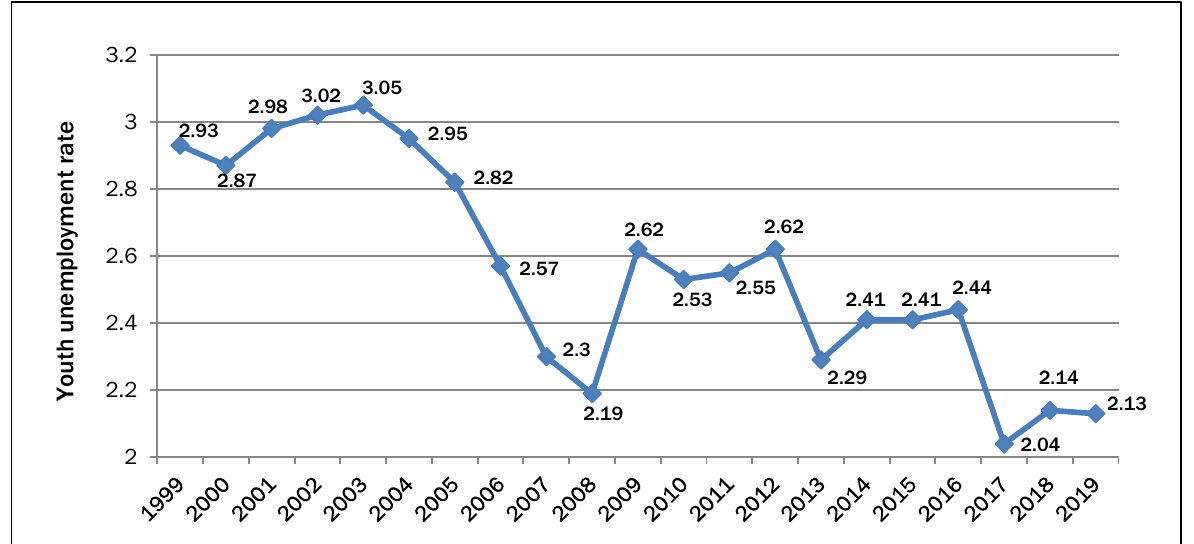
Figure 1. Youth Unemployment Rate in Nepal, 1999 – 2019